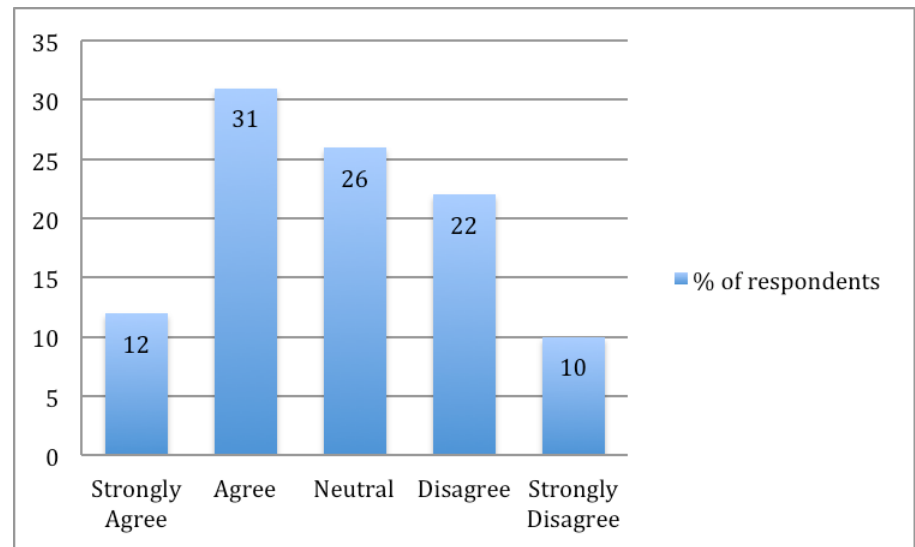
Figure 6. Suitable and relevant OER are difficult to find.